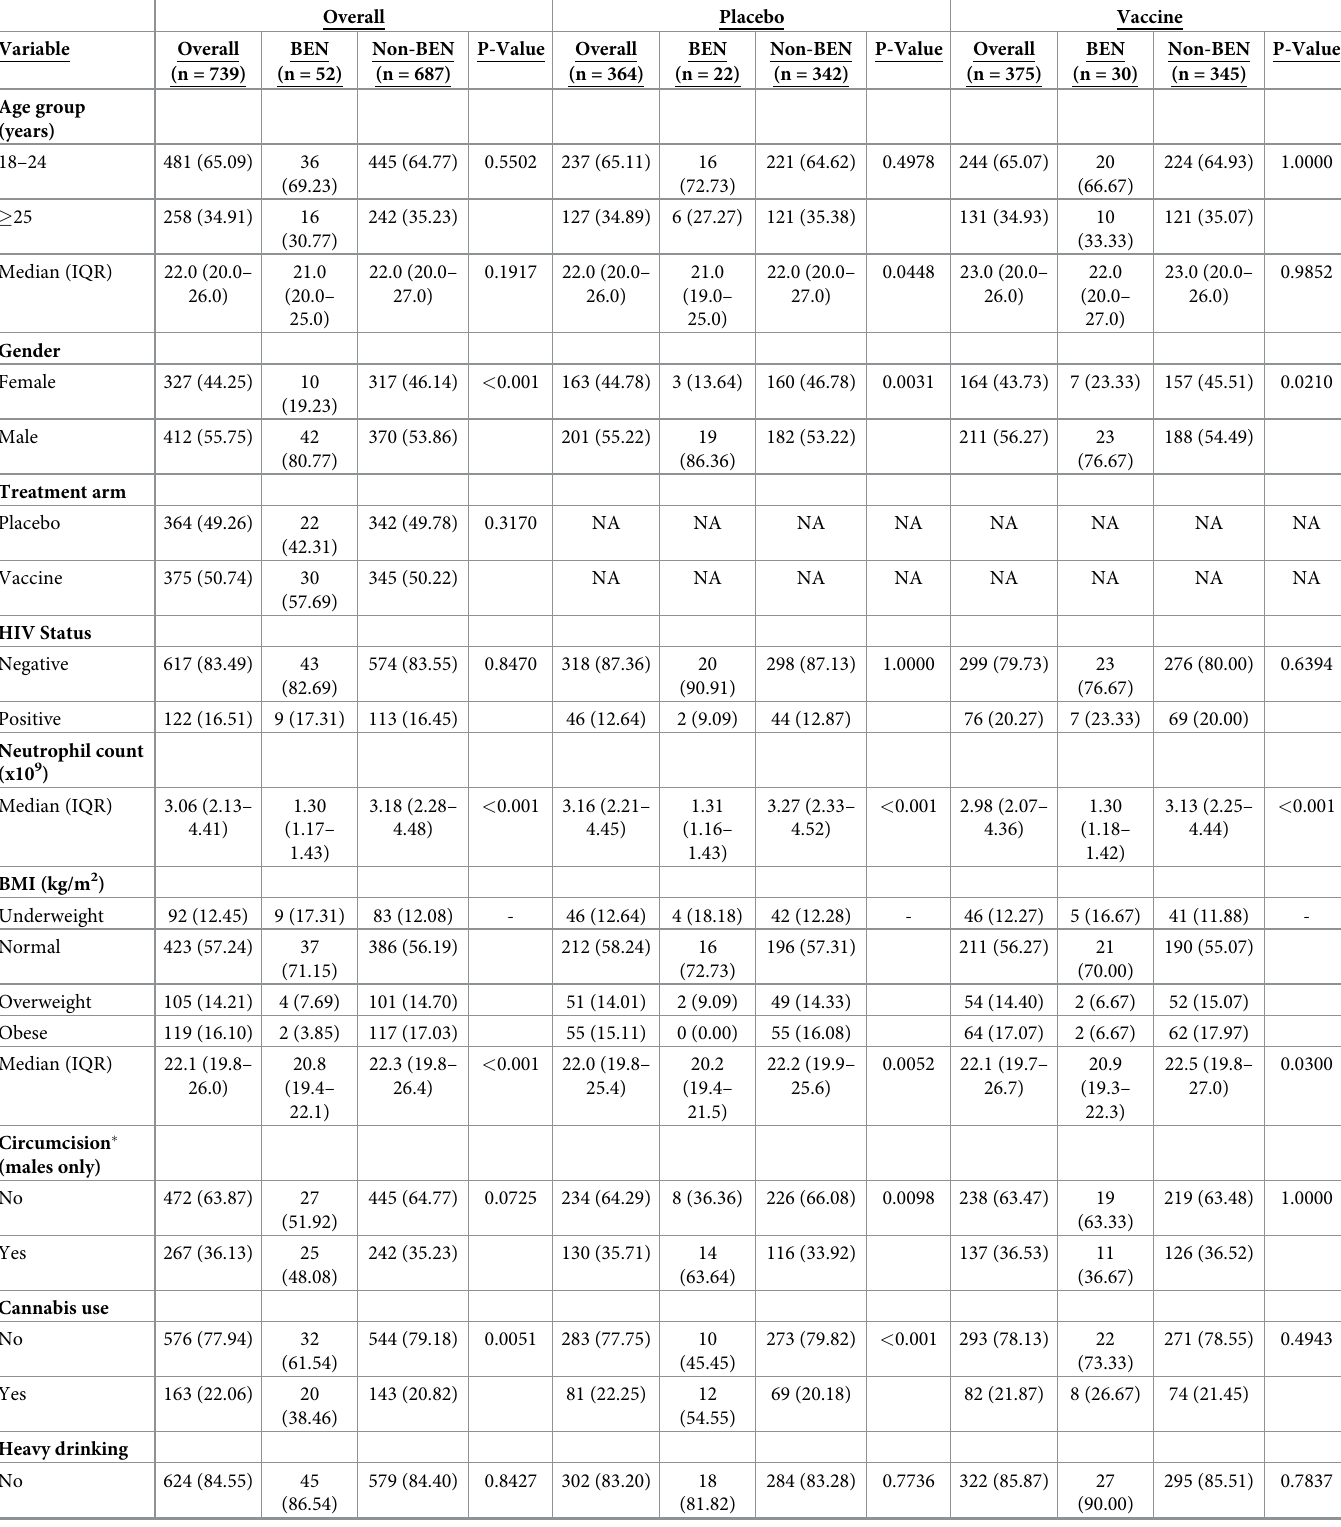
Table 1. Demographic and clinical characteristics of Black participants in HVTN